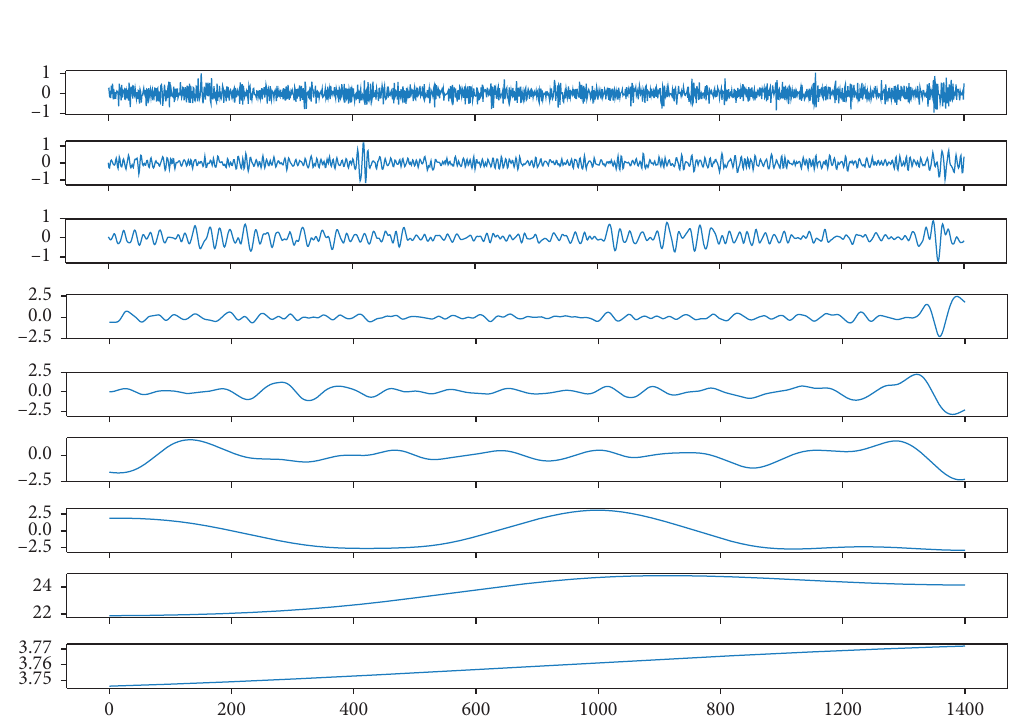
Figure 14: The EEMD decomposition graphs of DAX time